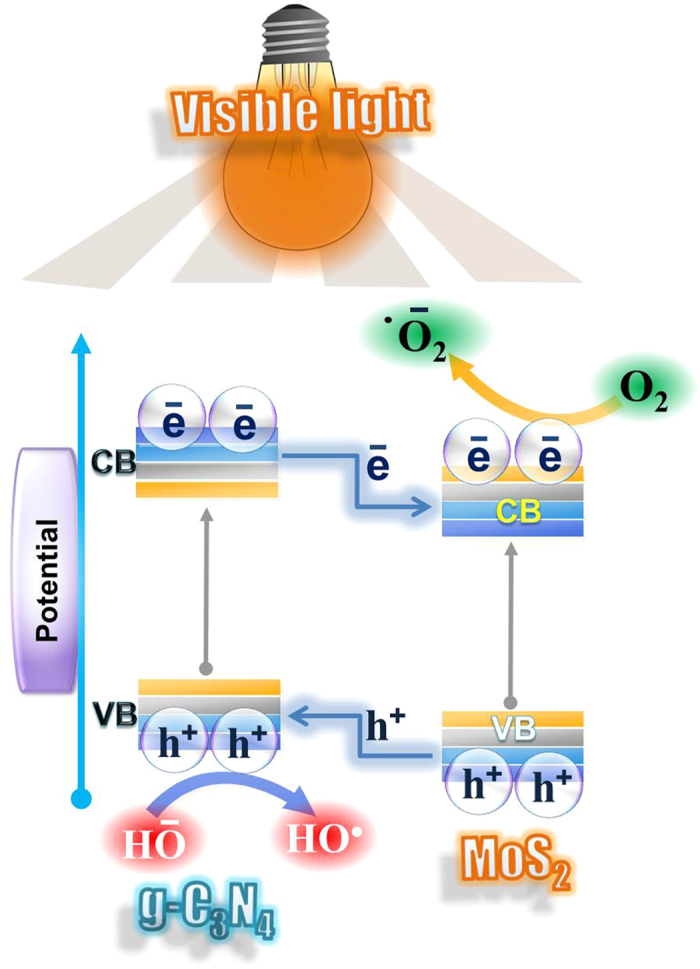
Proposed mechanism for the possible charge transfer movement and separation process occurred under visible photoirradiation over the MoS2-g-C3N4-1 heterostructure interface.